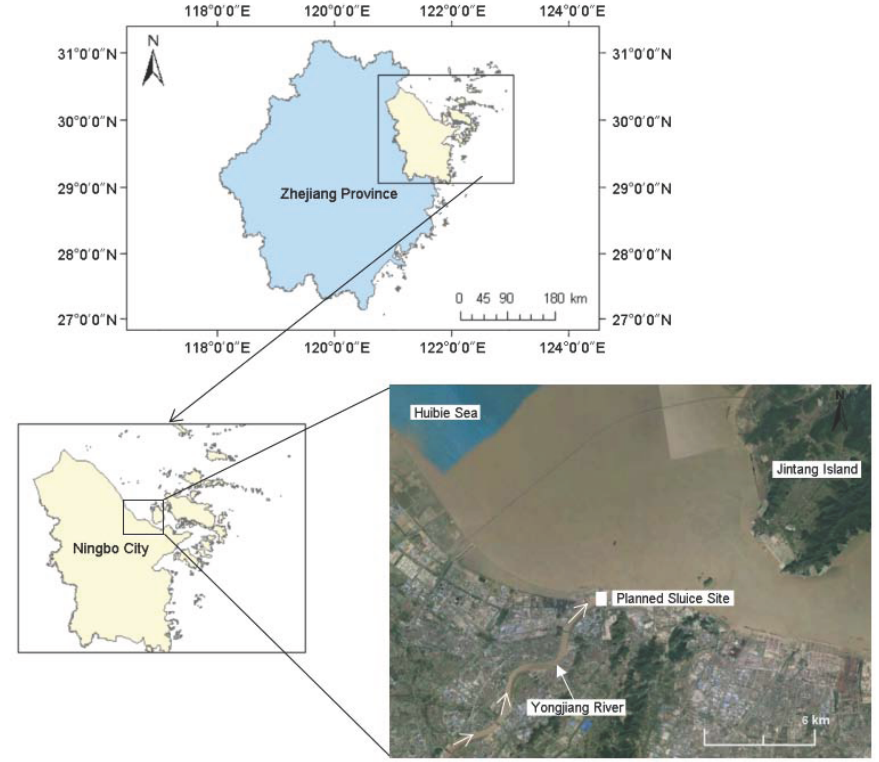
Figure 1. The study area: The lower reach below the Sanjiangkou in Ningbo is the Yongjiang River. The Yongjiang estuary is north to Huibie Sea in Hangzhou Bay and east to Jintang Island.